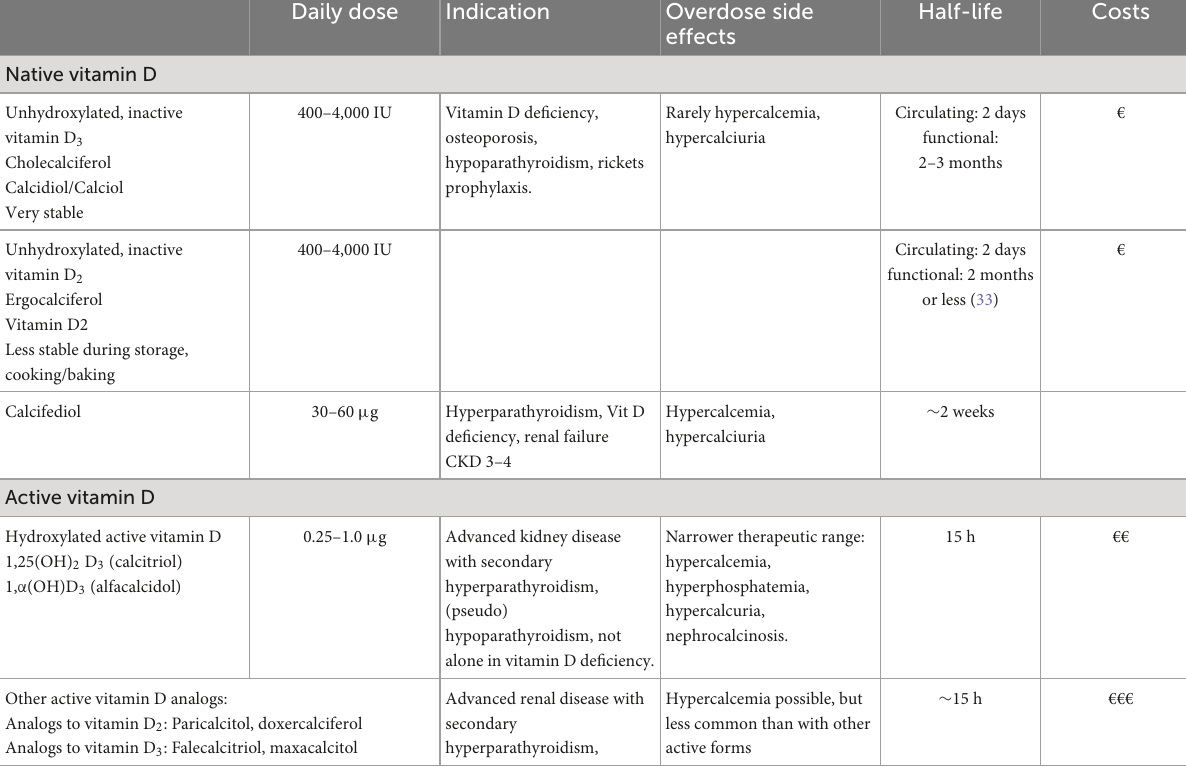
TABLE 1 Overview of available vitamin D preparations, adapted to Prietl B. et al. (4) indicated usual dosage recommendations apply to non-ICU